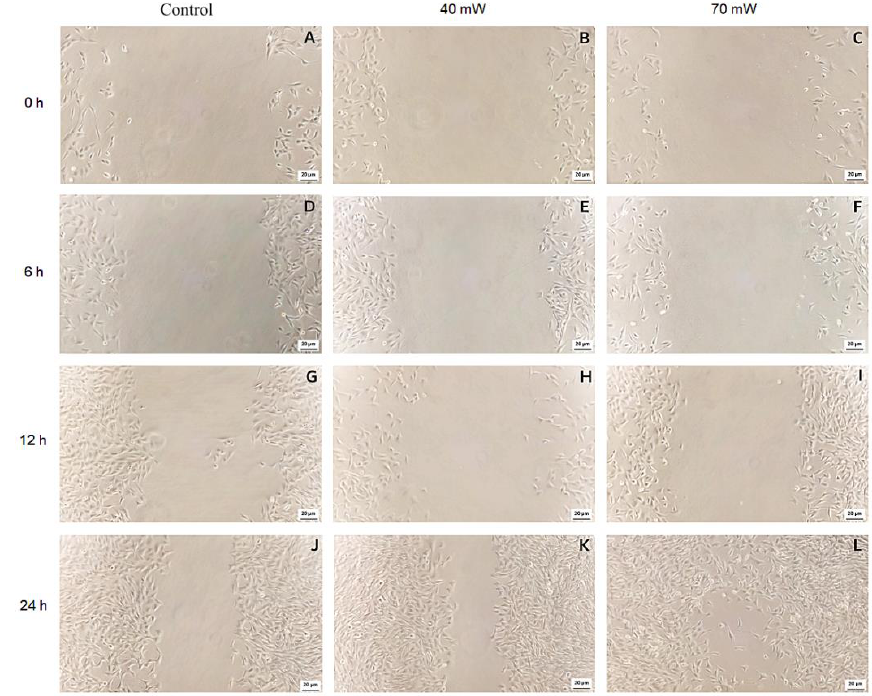
Figure 4. Closure of wound after 0 h: ( A ) Control, ( B ) LLL I 40 mW, ( C ) LLL II 70 mW; after 6 h: ( D ) Control, ( E ) LLL I 40 mW, ( F ) LLL II 70 mW; after 12 h: ( G ) Control, ( H ) LLL I 40 mW, ( I ) LLL II 70 mW; after 24 h: ( J ) Control, ( K ) LLL I 40 mW, ( L ) LLL II 70 mW.